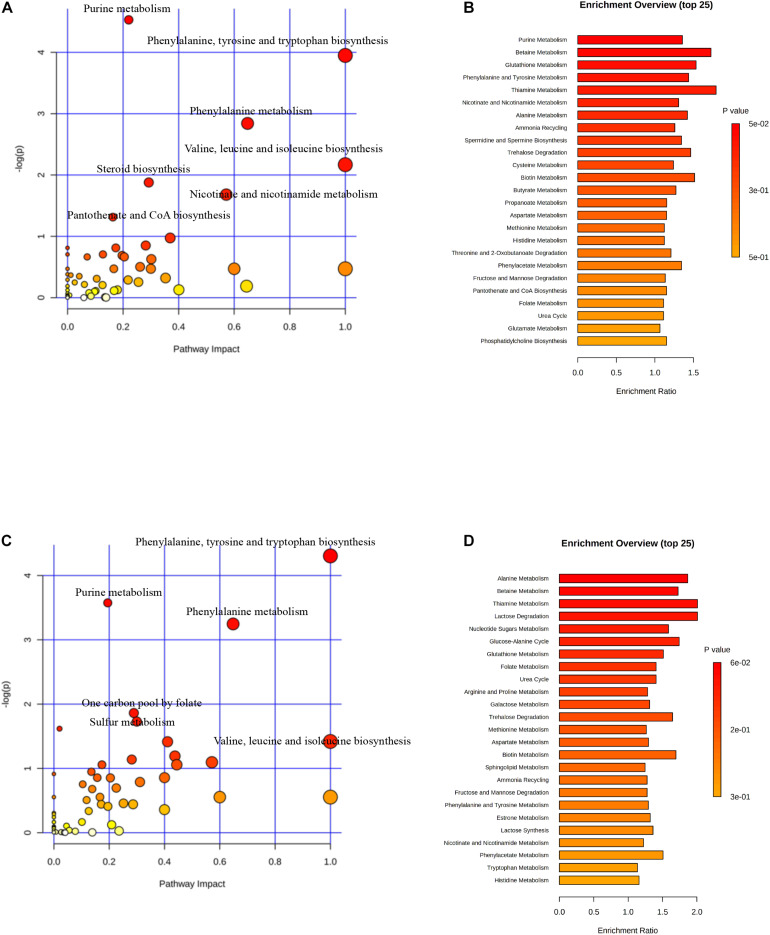
Analysis of metabolic pathways in SASCs, EASCs, and PASCs. (A) Analysis of metabolic pathways of differential metabolites between SASCs and PASCs. The color depends on the P-value, and the size of the circle represents the degree of correlation. (B) Top 25 enrichment of differential metabolites between SASCs and PASCs, and the P-value represents the enrichment level, the darker the orange, the greater the P-value; the length of the bar represents the amounts of metabolites. (C) Analysis of metabolic pathways of differential metabolites between SASCs and EASCs. (D) Top twenty-five enrichment of differential metabolites between SASCs and EASCs.